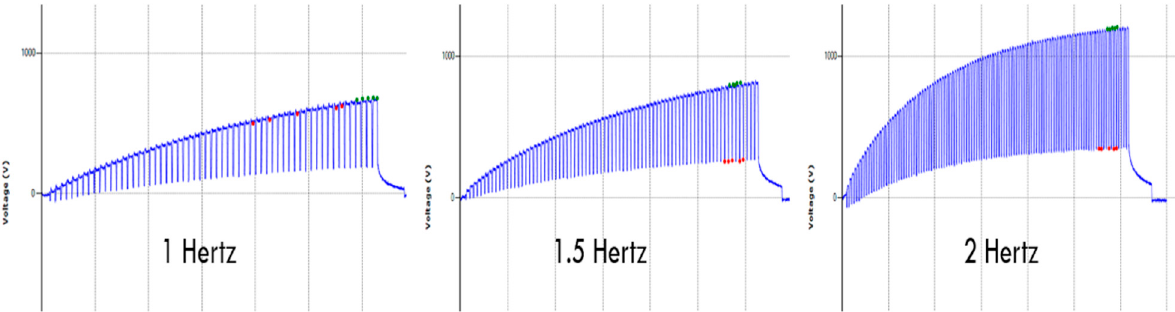
Figure 6. Effect of different frequency on the electrostatic waveform, peak voltage, and amplitude (peak-to-peak voltage).